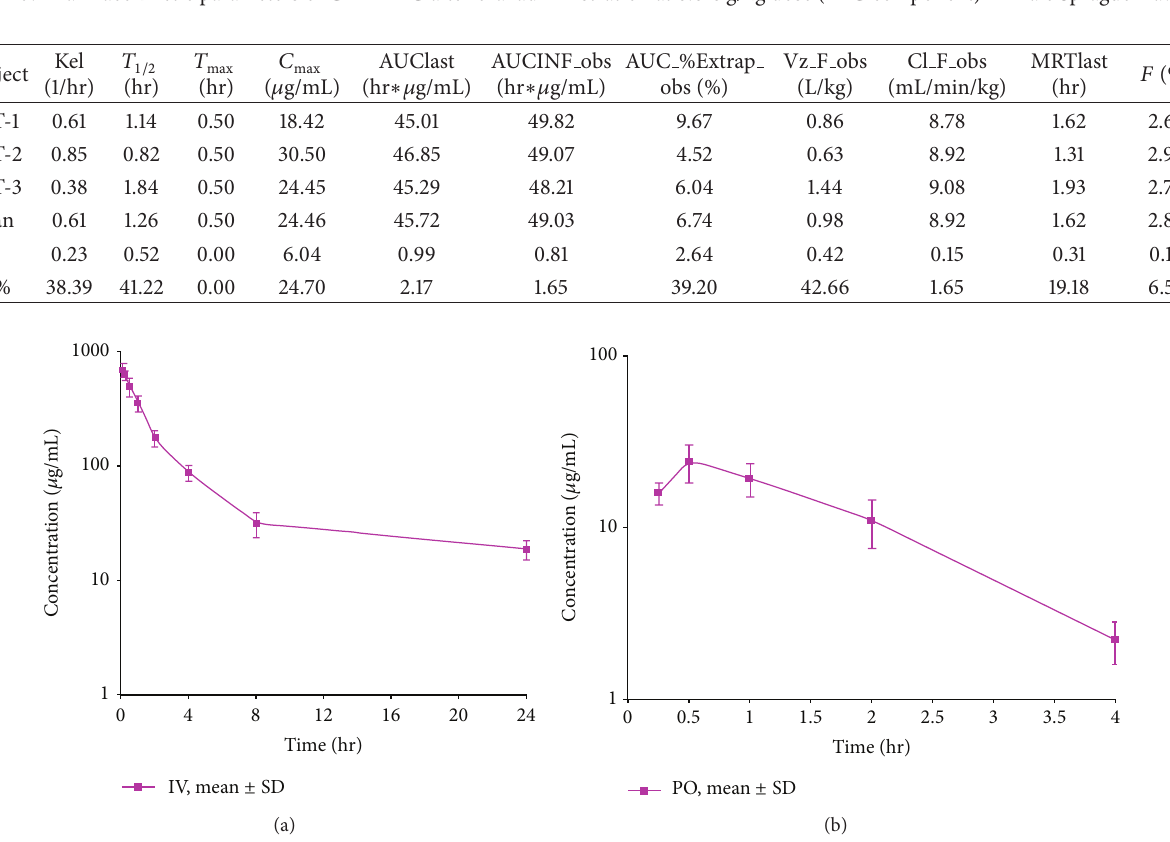
Figure 7: Mean Concentration time profile of CrEL (CEL-PEG) after (a) intravenous administration at 0.018 g/kg (PEG component) dose to SD rats (b) oral administration at 0.018g/kg (PEG component) dose to SD